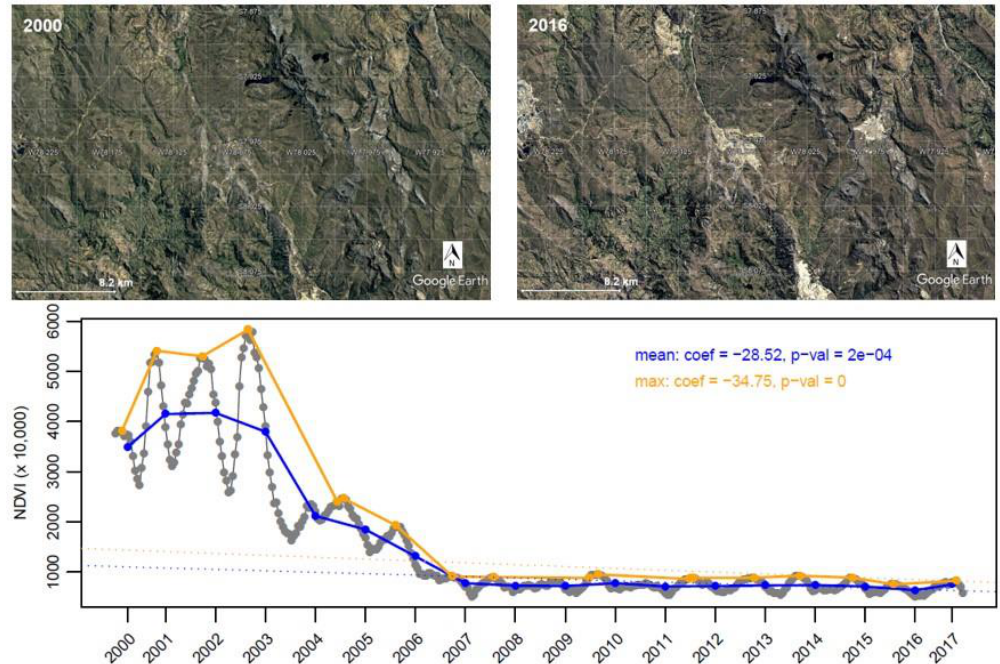
Figure 13. In the upper panels, high spatial resolution imagery from Google Earth Pro shows browning in the Andean Highlands near La Libertad between 2000 and 2016. Expanding mine footprints result in rapid decreases in NDVI. The accompanying graph shows the entire time-series of the NDVI data and fitted Thiel-Sen trends for NDVI-mean (blue) and NDVI-maximum (orange) for a pixel located at